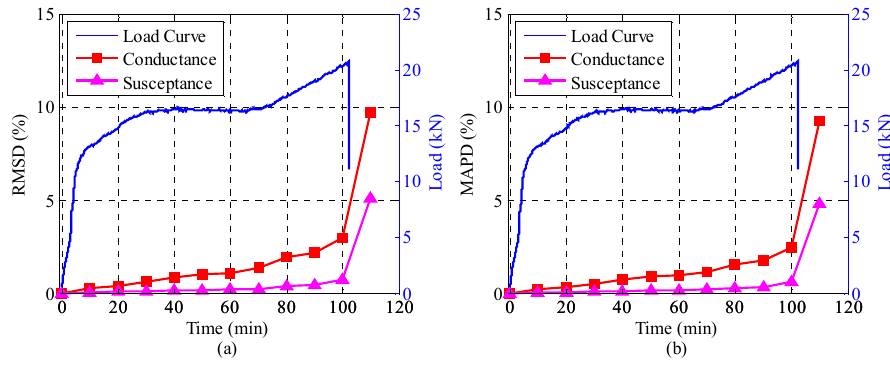
Figure 9. The damage metrics of the conductance and susceptance for SA-2 during the test. ( a ) RMSD, ( b ) MAPD.